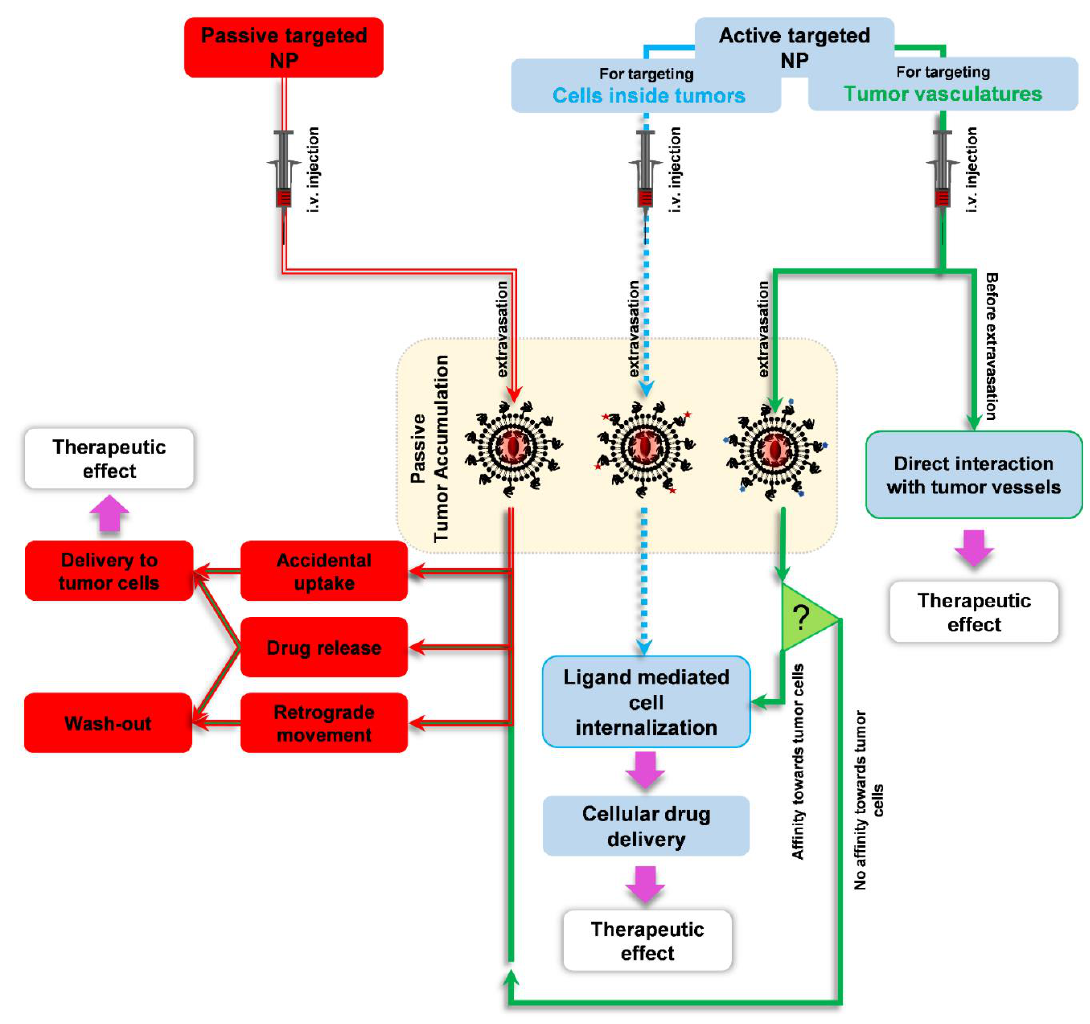
Figure 10. Schematic of targeting tumor tissue by means of passive or active targeted nano-particles (NP). A passive-targeted NP (red double line) requires passive extravasation and accumulation inside the tumor where the NP can release the payload, accidently being taken up by cells or being washed out from the tumor. An active-targeted NP that is designed to interact with cells inside the tumor (blue square dashed dot line) still requires EPR-based tumor accumulation similar to a passive-targeted NP. However, in contrast to a passive-targeted NP, a targeted NP can actively interact with cells expressing the target marker and consequently enter the targeted cell. When a vascular-targeted NP (green solid line) passes through a tumor, two scenarios may happen; this NP might recognize vascular endothelial cells and subsequently be taken up, or it may still passively extravasate into the tumor interstitium. If the targeted vascular marker is also expressed in tumor cells, then vascular-targeted NPs can actively interact with and be internalized by tumor cells. When tumor cells do not express the vascular marker, vascular-targeted NPs have the same fate as plain and non-targeted NPs have.